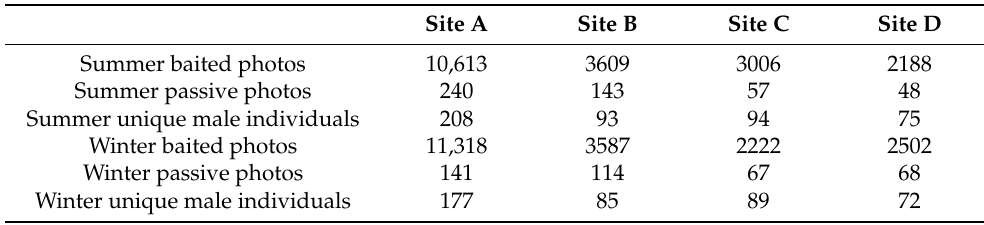
Table 1. Numbers of images and identified male white-tailed deer. Total number of male white-tailed deer ( Odocoileus virginianus ) images collected and total number of unique male deer identified during summer (2015) and winter (2016) baited and passive camera surveys in southwestern Georgia, USA.